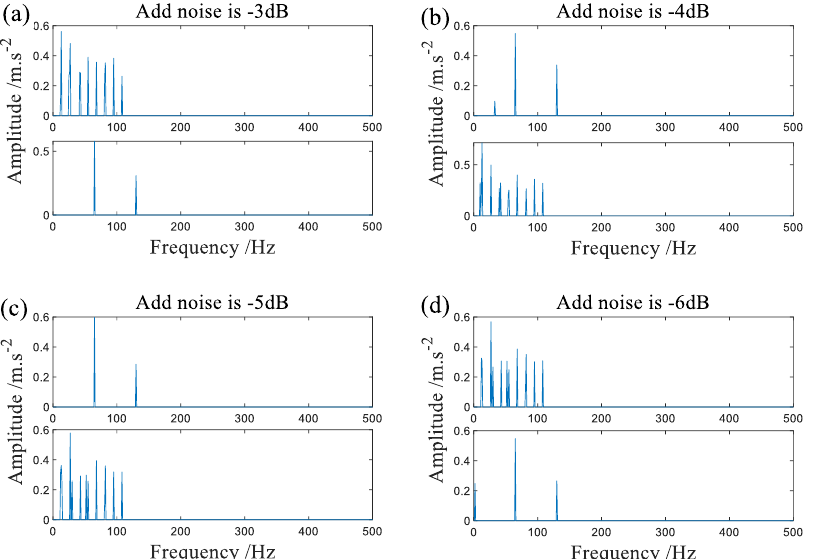
Figure 20. The signal is processed by SMF − DPC − OMP after additional noise, ( a – d ) is the case where − 3 dB, − 4 dB, − 5 and − 6dB of noise are added, respectively.